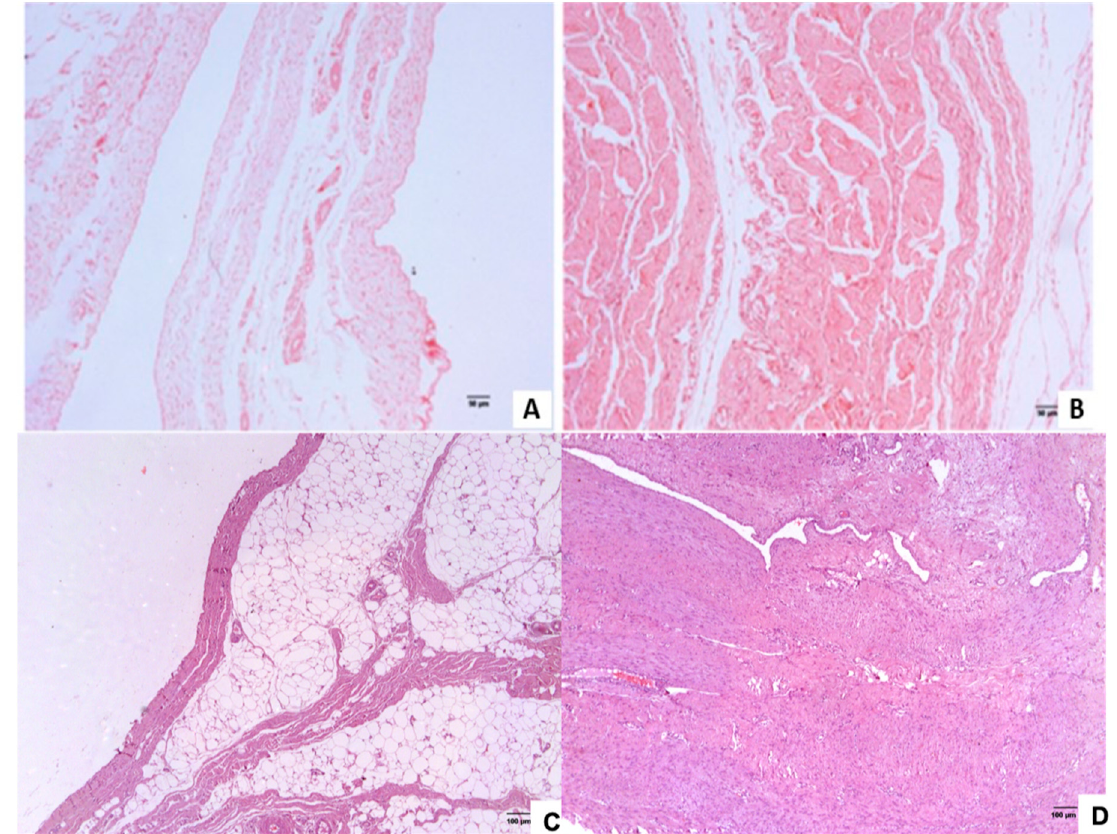
Figure 2. Histopathological slide stained with hematoxylin and eosin (HE). Legend: ( A ) sample from the scrotal hernia (SH)-control group and ( B ) sample from the SH-affected group. A larger number of connective fibers is observed in the sample of the SH-affected group than in the sample from the SH-control group. ( C ) Sample from the umbilical hernia (UH)-control group and ( D ) sample from the UH-affected group. Connective tissue interspersed with adipose tissue is observed in the sample of the UH-control group, while in the sample from the UH-affected group, only proliferated connective tissue is observed.